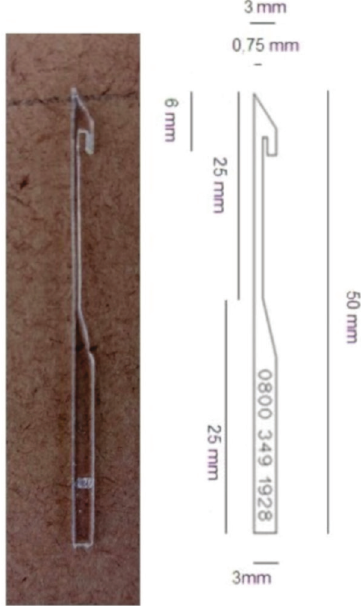
Fig. 1. Visual tag for fish described in the